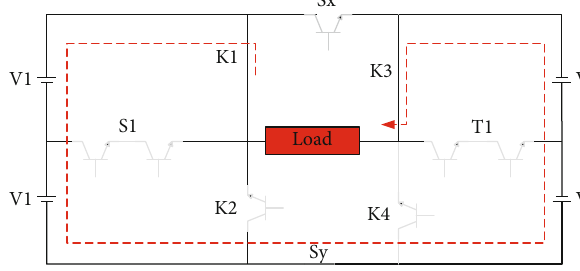
Figure 18: Current fl ow for the 16 th switching pattern.